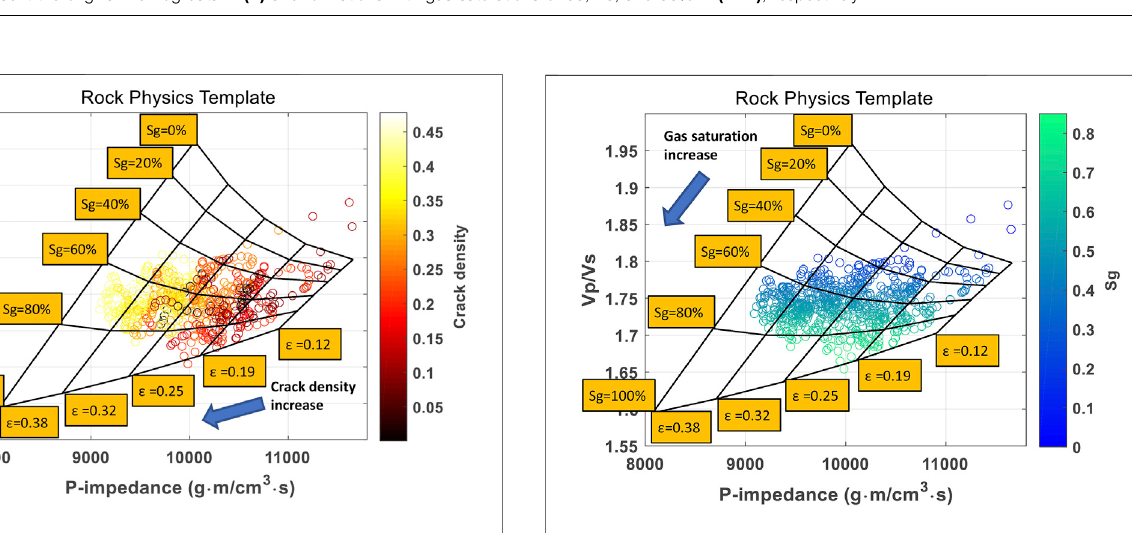
FIGURE 8 | Rock physics template analysis for the interpretation of crack density and gas saturation from cross-plot between the V p / V s and P-impedance. The data points are from Well-1 and color-coded by gas saturation log. The arrow shows the direction of increasing gas